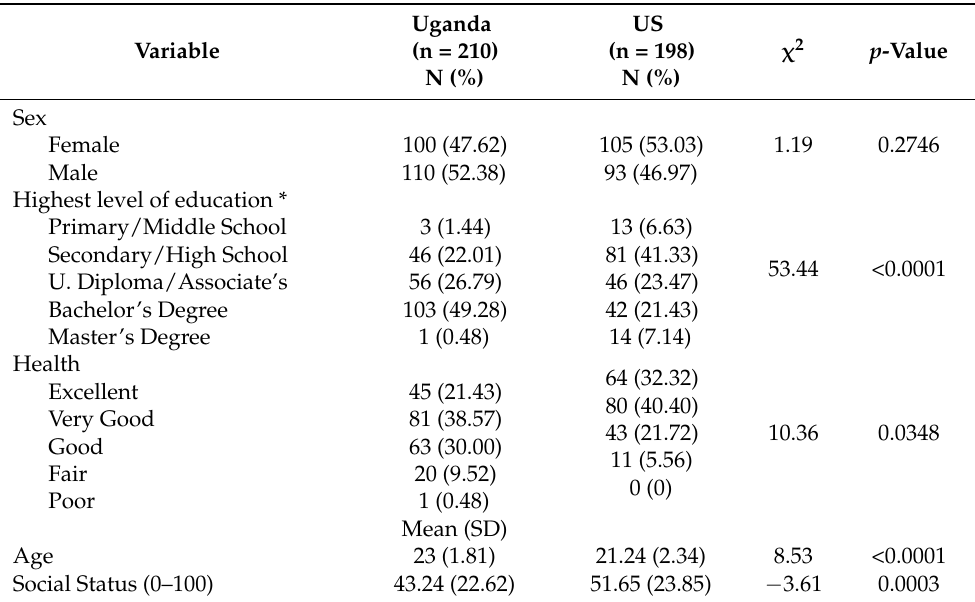
Table 1. Analytic sample characteristics: Sex, age, health, education, and social status among survey participants in Uganda and in the U.S. (n =